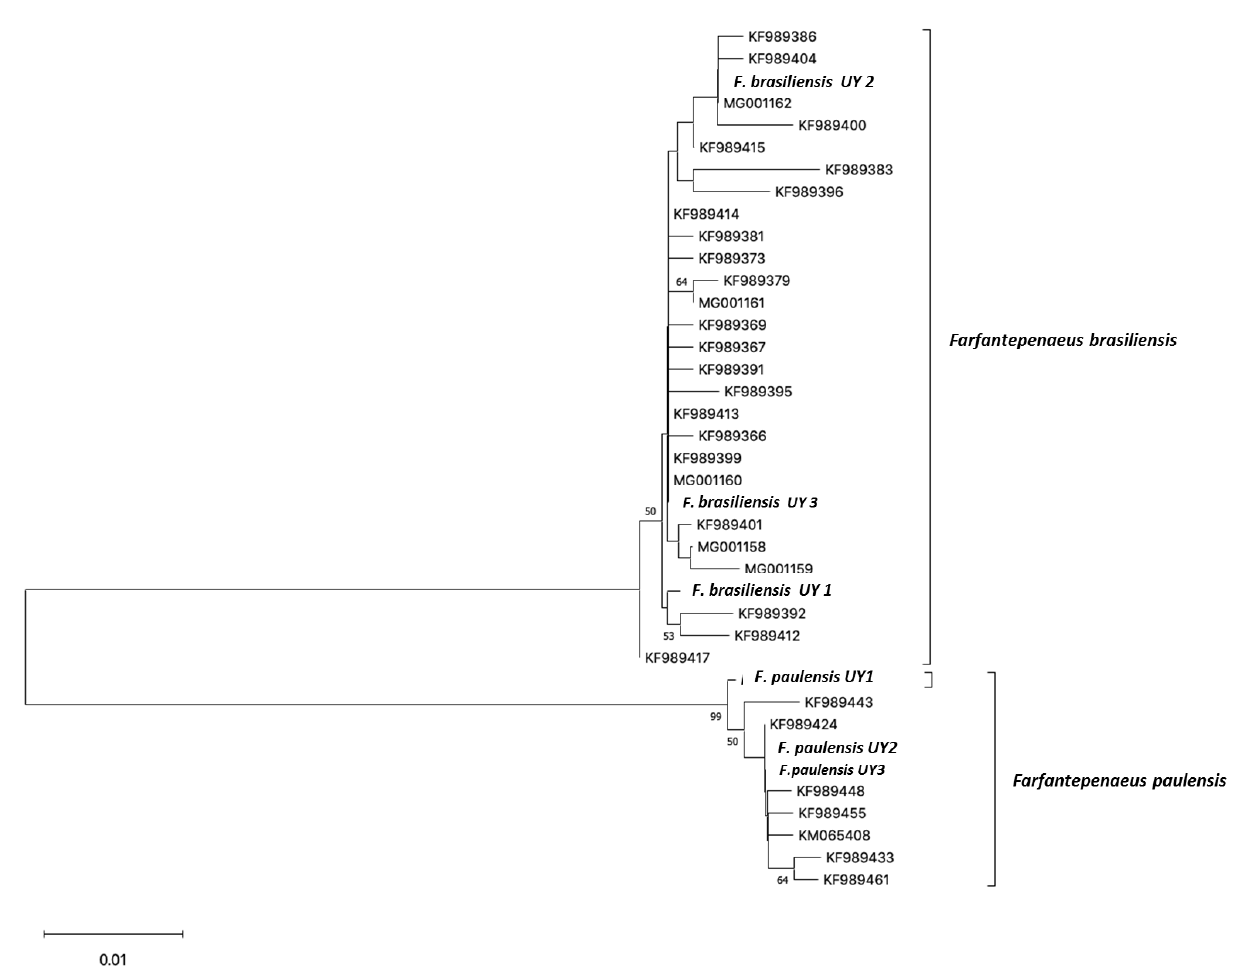
Figure 4. Maximum likelihood tree of 39 sequences of Farfantepenaeus paulensis and F. brasiliensis . Names in bold are 3 suspected individuals of F. paulensis (named as F. paulensis UY 1 to 3) and 3 of F. brasiliensis (named as F. brasiliensis UY 1 to 3), captured in April 2019 in the Rocha lagoon. The percentage of trees in which the associated taxa clustered together is shown next to the